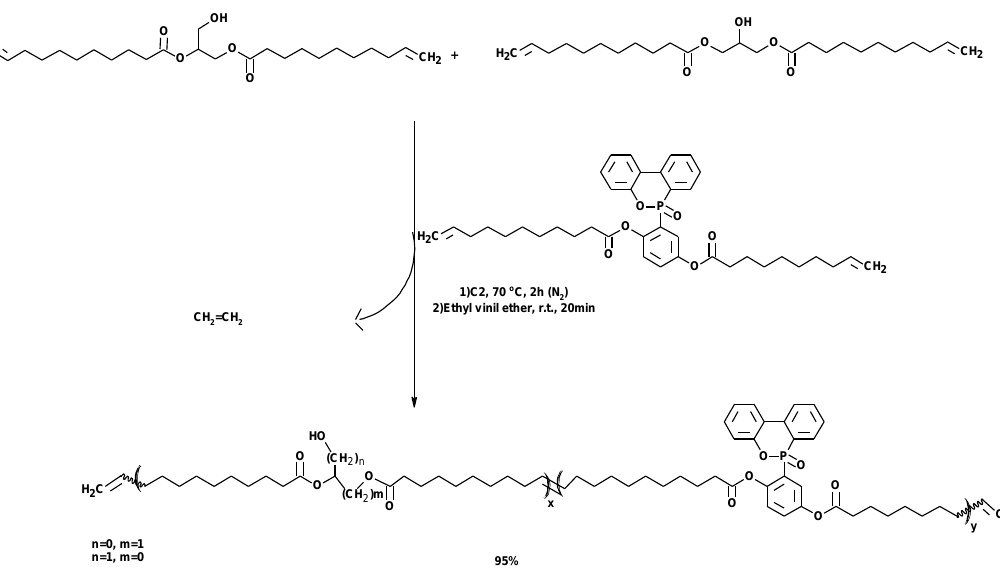
Figure 19. Dimer synthesis of alkenyl fatty acids, using 1,3-DCH as a linker.